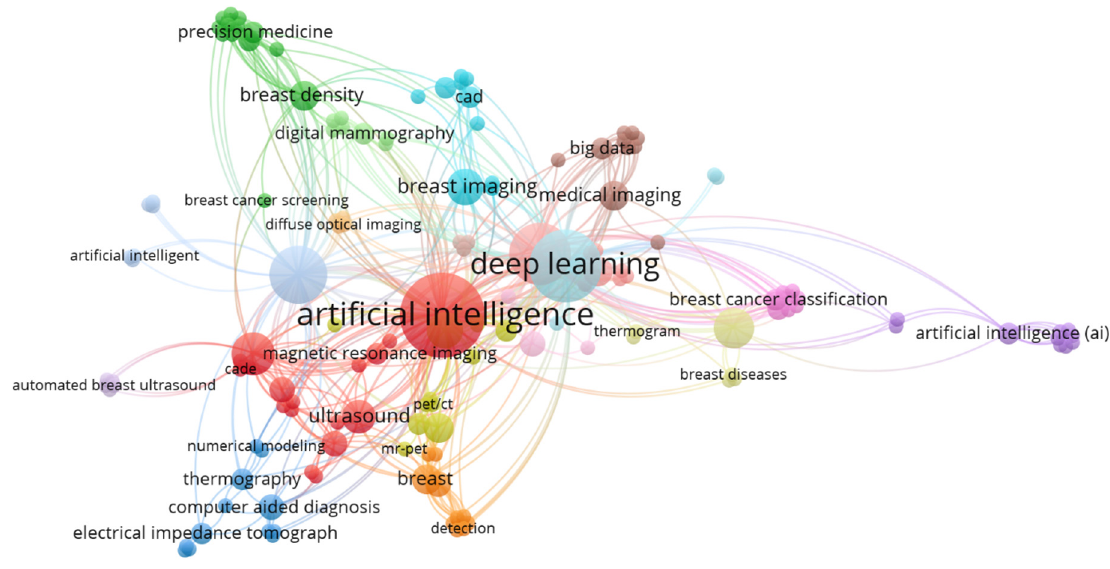
Figure 15. Indexed keywords co-occurrence mapping.